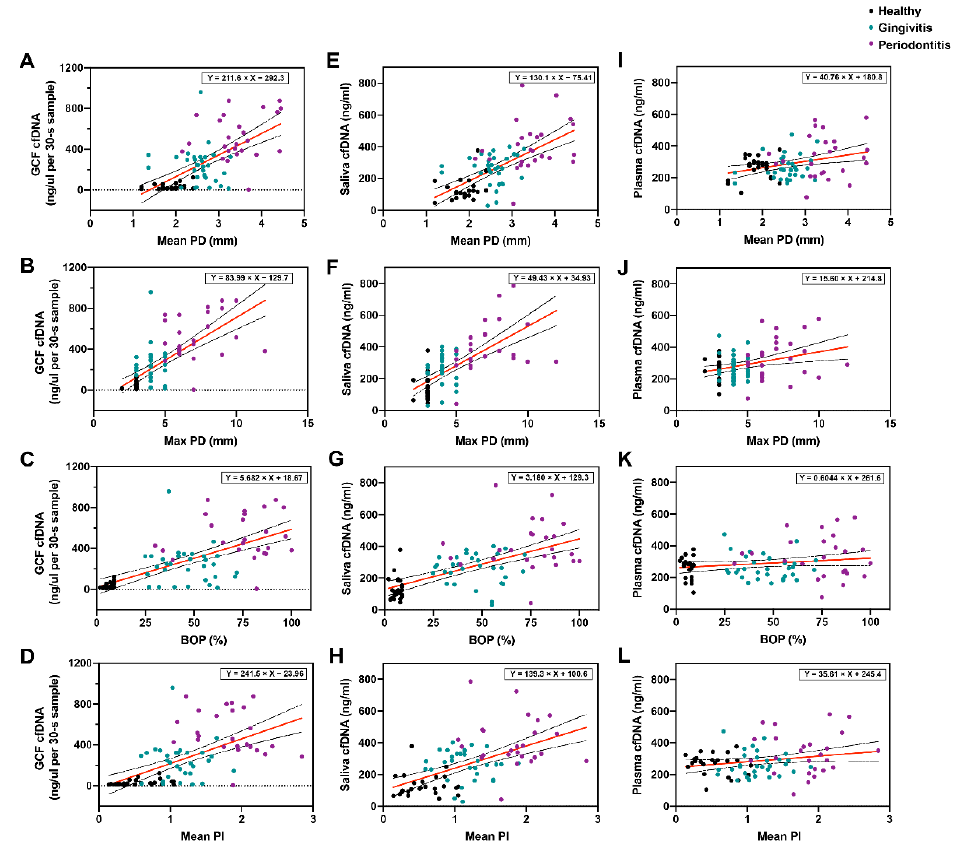
Figure 2. The relationships between cfDNA levels and periodontal parameters. ( A – D ) Correlations between GCF cfDNA (ng/uL per 30-s sample) and periodontal parameters. ( E – H ) Correlations between saliva cfDNA (ng/mL) and periodontal parameters. ( I – L ) Correlations between plasma cfDNA (ng/mL) and periodontal parameters. Lines represent mean and 95% confidence interval. Pearson correlation analysis and linear regression analysis were conducted. n =